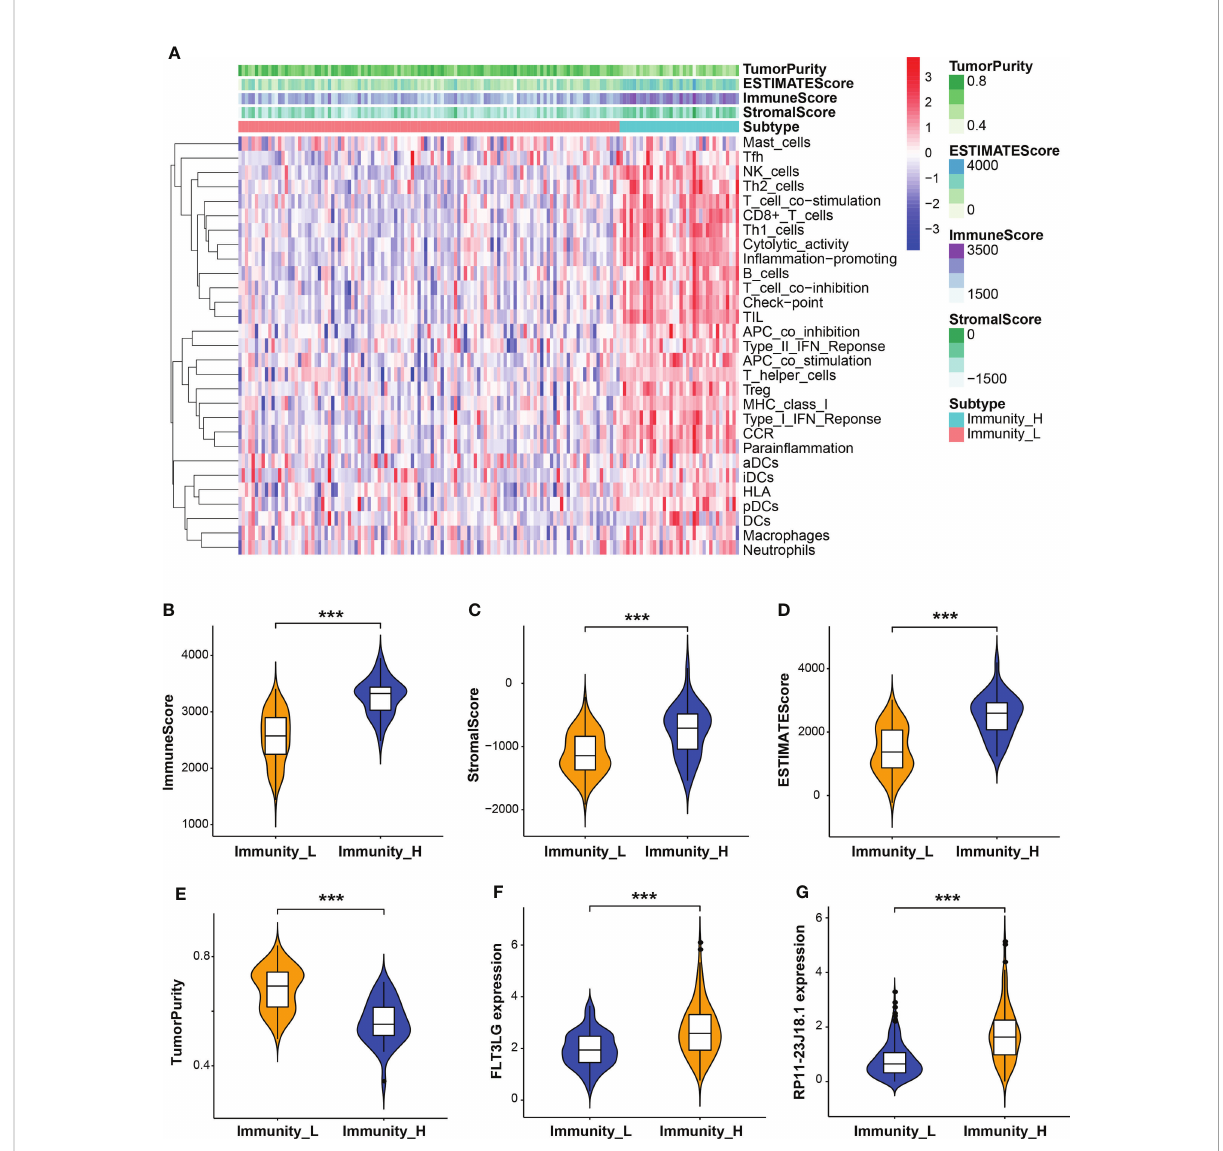
FIGURE 4 Evaluation of tumor microenvironment (TME). (A) Heatmap of immune cell, stromal cell and ESTIMATE scores and tumor purity in high and low immune activity groups. (B – E) Relationship between immune cell, stromal cell and ESTIMATE scores and tumor purity with immune activity in the TME. (F, G) Relationship between FLT3LG and RP11-23J18.1 expression and immune activity. *** p <